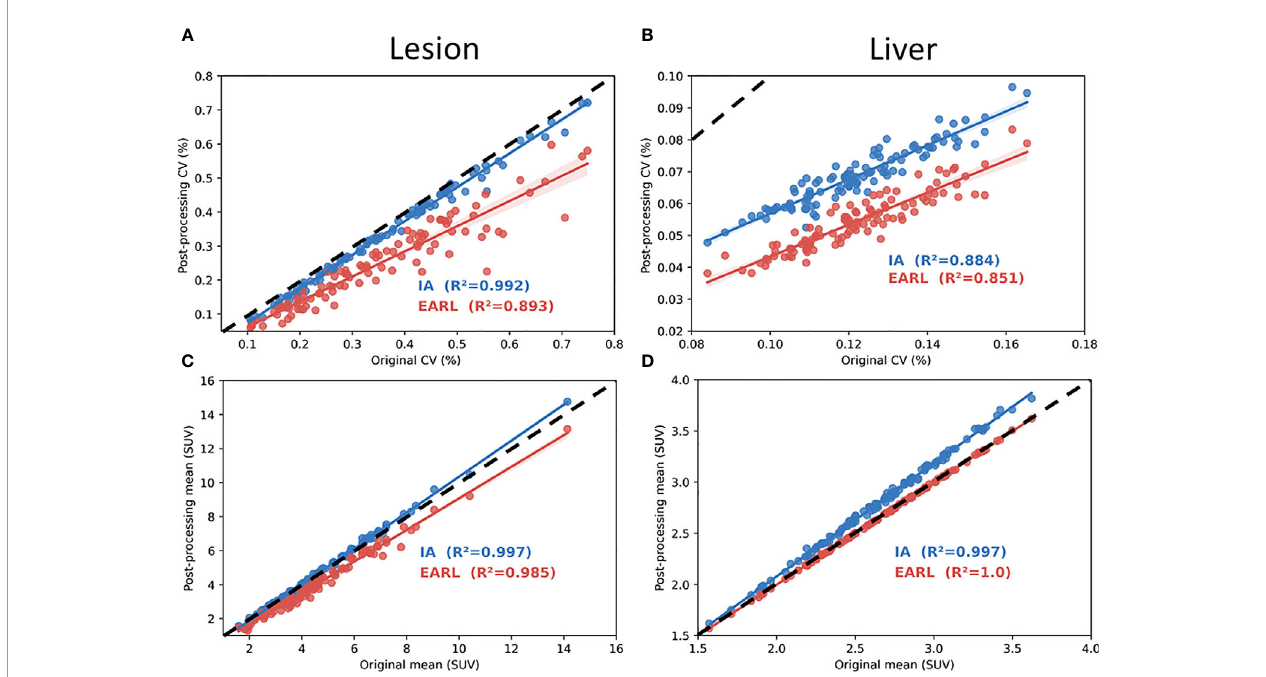
FIGURE 3 | Coef fi cient of correlation plot with R 2 value in lesions (A, C) and healthy liver (B, D) . (A – D) show respectively coef fi cient of variation (CV) and mean SUV calculated from AI and EARL1-like image in function of original images. Dotted line represents the identity line.